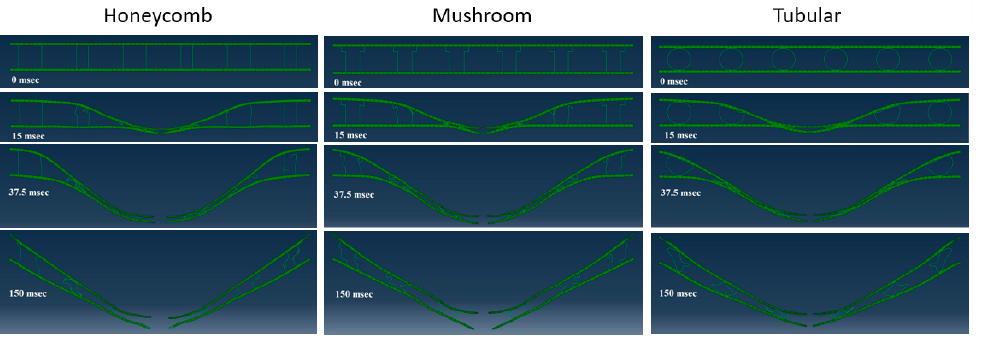
Figure 14. Kinetic energy categorized by core shape, plate thickness, and core–core spacing.